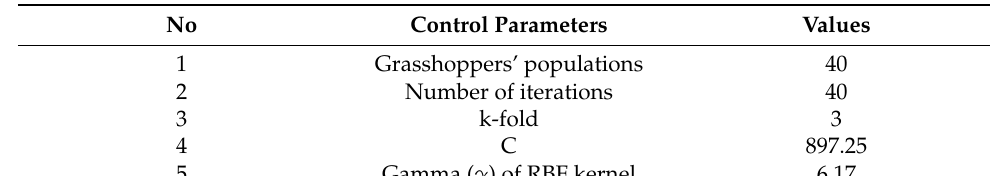
Table 6. Control parameters of the best developed GOA-SVM model.